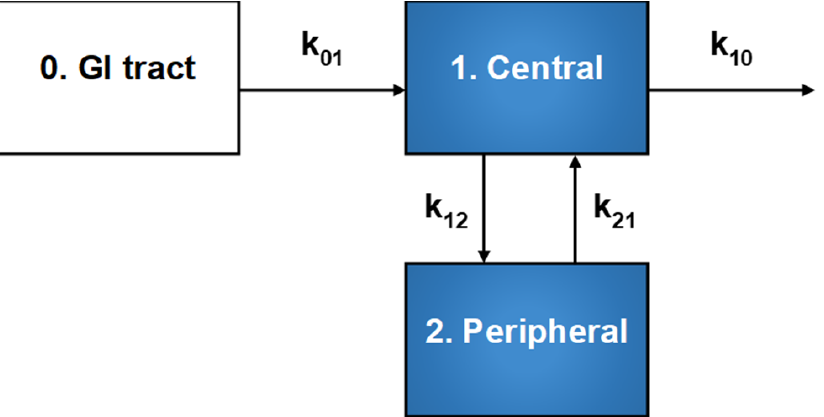
Figure 4. Schematic illustration of the two-compartment model with first-order input and elimination rate used to describe the median concentration-time profiles of all kratom alkaloids. Compartments 1 and 2 represent the central and peripheral compartments, respectively. The model was parameterized with the microconstants k 01 , k 12 , k 21 , and k 10 ; k 01 (or k abs ) is the rate constant for absorption into the central compartment constant, k 12 and k 21 are the intercompartmental distribution rate constants, and k 10 is the rate constant for loss from the central compartment. Table 2. Compartmental model-derived pharmacokinetic estimates of kratom alkaloids in healthy adult participants ( n = 5 who completed the study) administered a well-characterized kratom product (2 g) as a tea.